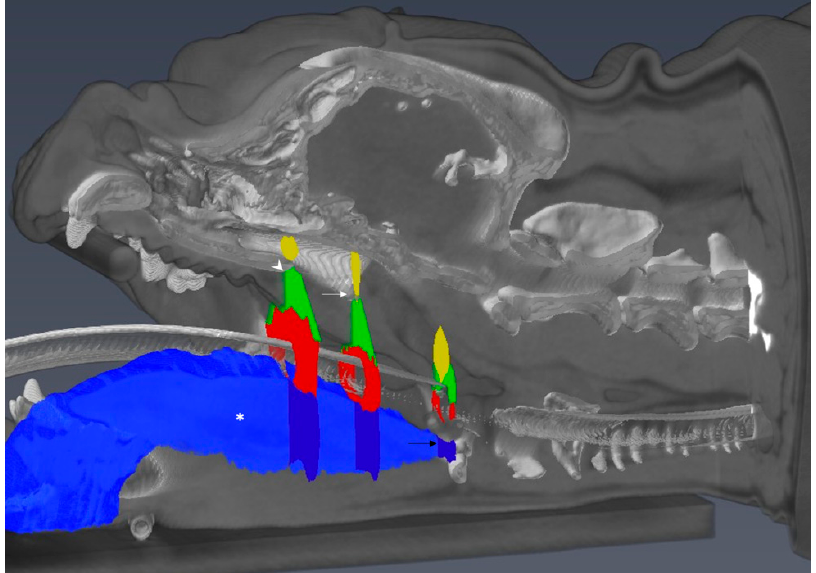
Figure 2. Reformatted 3D model of computed tomography scans of an English bulldog skull. Using segmentation software, the tongue volume has been assessed within defined borders (asterisk; depicted in shaded blue and sliced on a para-midsagittal plane for illustration purposes) and relative position of cross-sectional areas (white arrowhead: transverse plane 1 at the caudal tip of the hard palate; white arrow: transverse plane 2 at the caudal tip of the hamulus of the pterygoid bone; black arrow, transverse plane 3 cranial to the cranial border of the basihyoid bone).